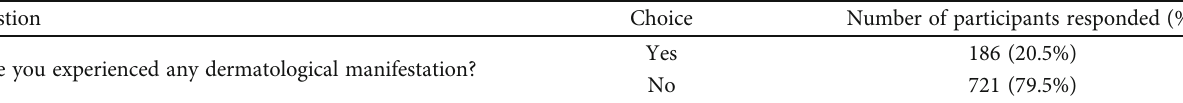
Table 5: The participants have shown dermatological a ff ection of the total involved participants.